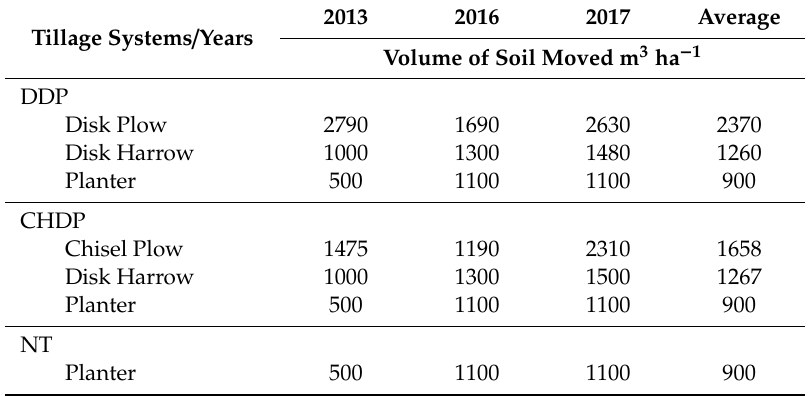
Table 7. Volume of soil moved for each operation in the tillage systems.